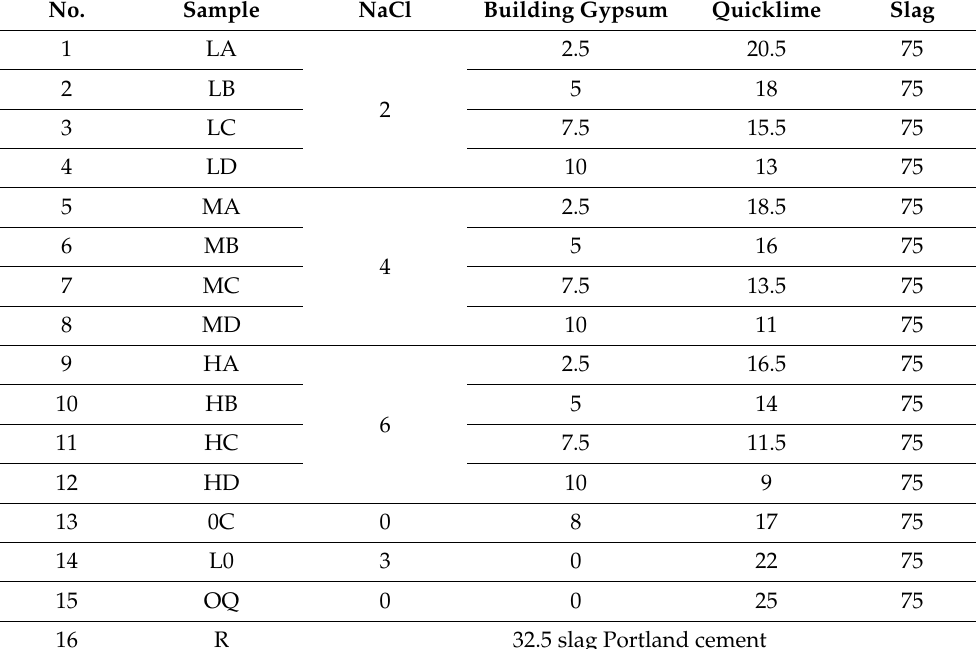
Table 4. Experimental items.